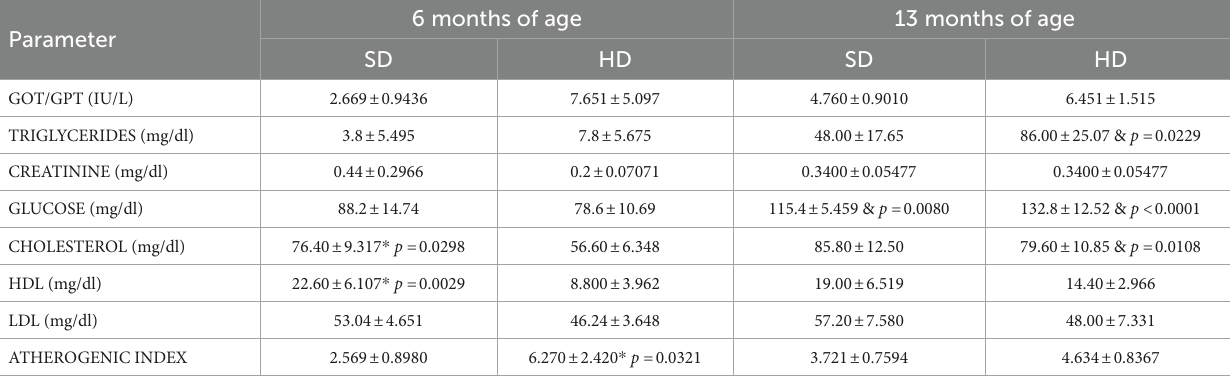
TABLE 2 Biochemical parameters.